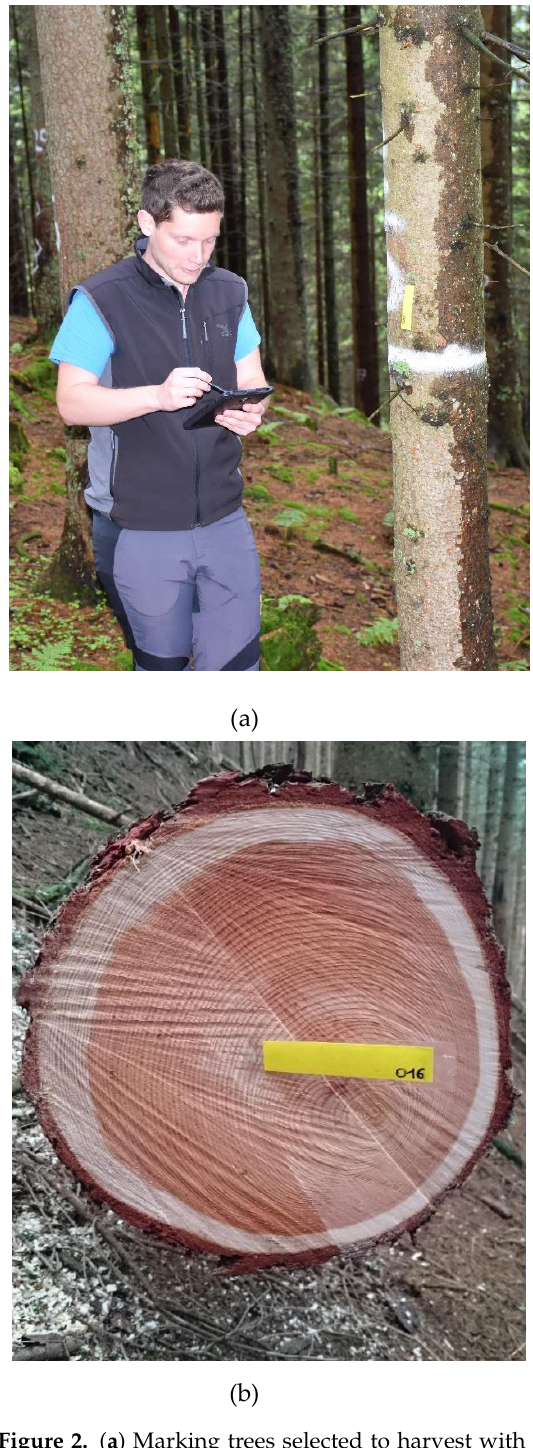
Figure 2. (a) Marking trees selected to harvest with RFID tags (yellow) fixed at breast height by single-stapling and using the Treemetrics Forest app on a tablet in the field to perform the marking process. (b) RFID re-marking of the trees by forest workers with a stapler by single-stapling on the cutting surface.